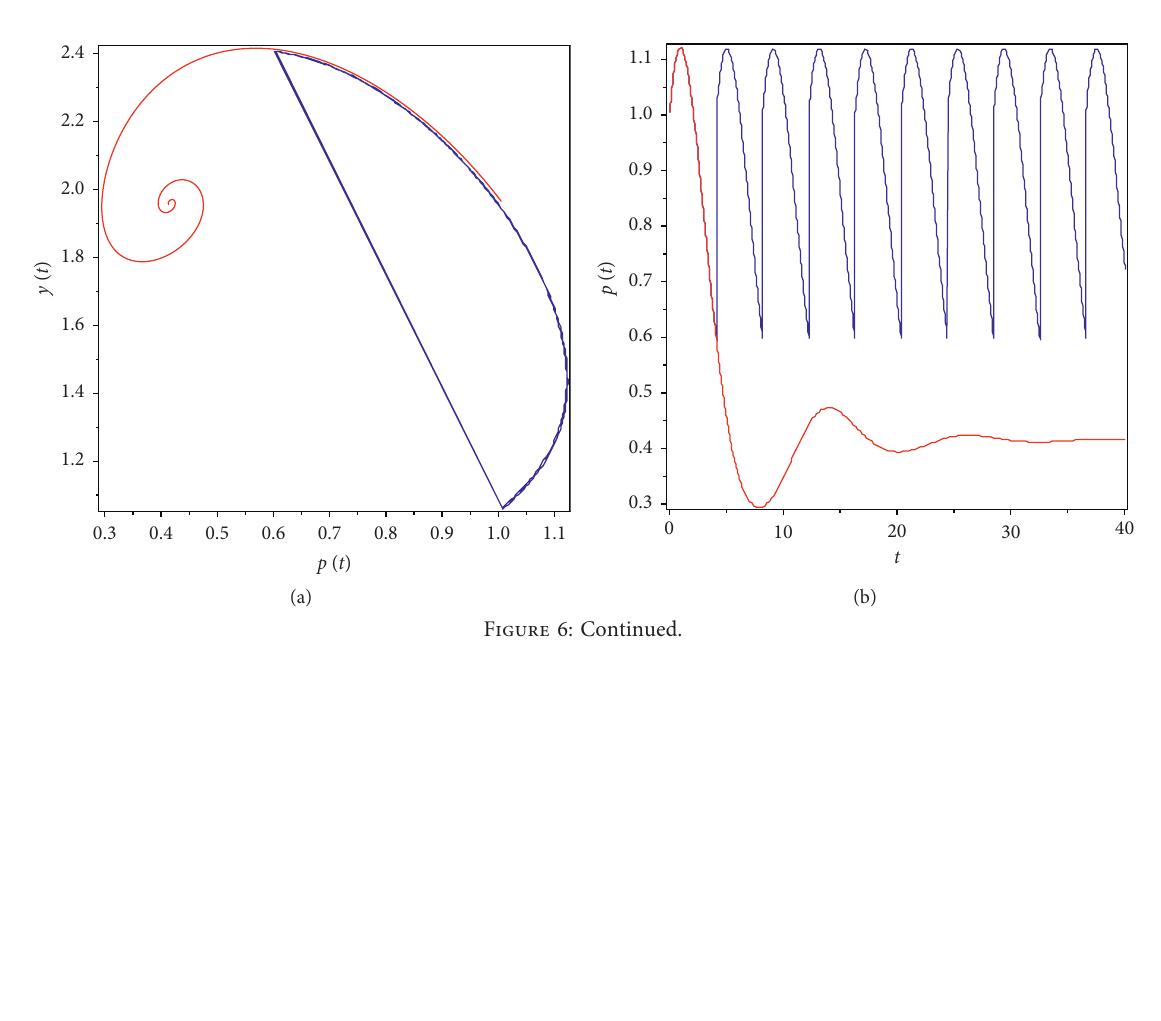
Figure 5: Phase portrait and time series of system (7) when F k � 1 . 8 , a � 0 . 15 , τ � 0 . 6 , p � 0 . 6 , θ � 0 . 8 , δ � 0 . 25 , and β � 0 .